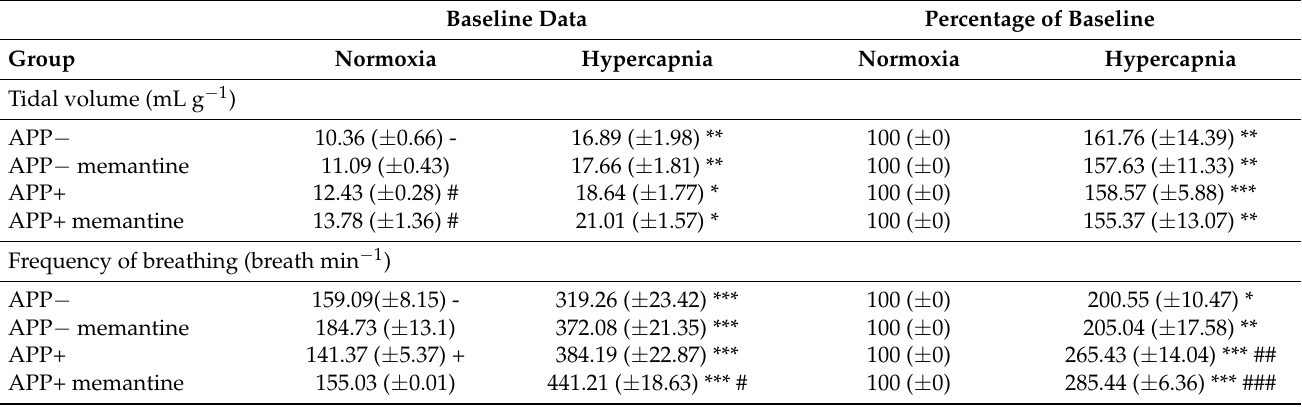
Table 3. Tidal volume (V T ) and frequency of breathing (F) baseline values during air breathing (normoxia) and hypercapnia in APP+ and APP − mice before and after memantine injection. In the two right columns, V T and F during the respiratory response to hypercapnia are expressed as a percentage of baseline values in normoxia.